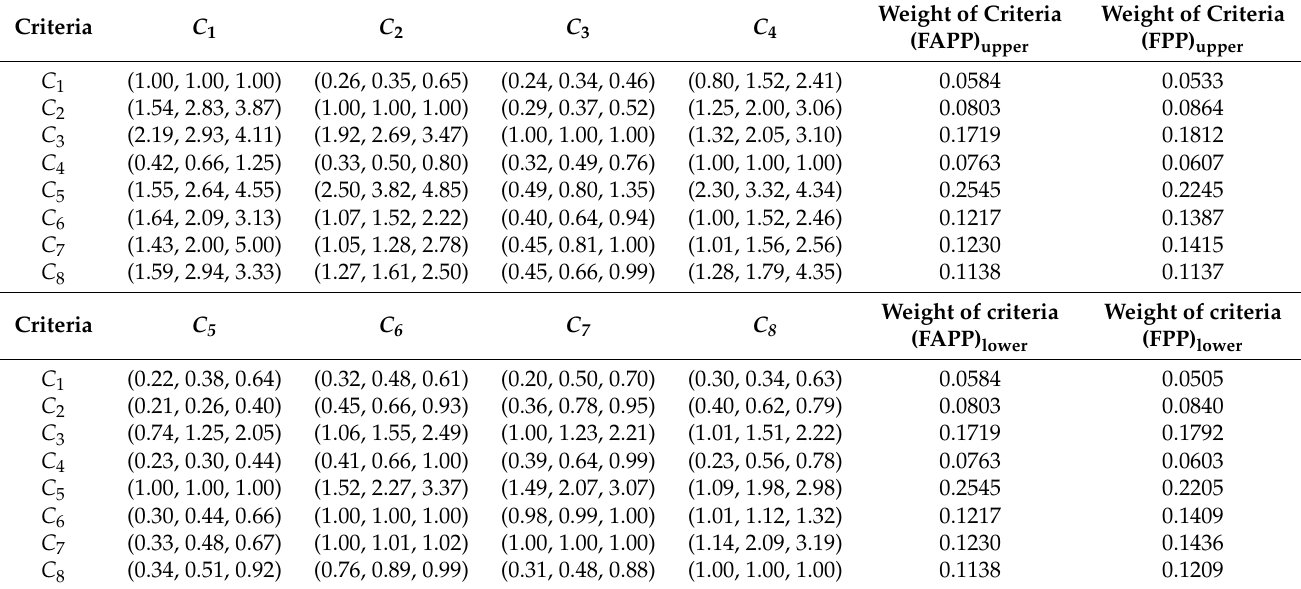
Table 1. The fuzzy pairwise comparison matrix of sustainability criteria and weights